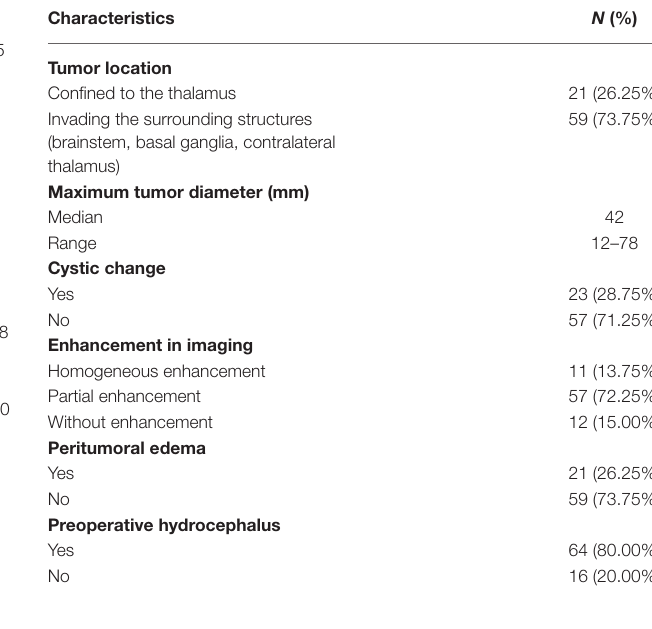
TABLE 2 | Summary of preoperative imaging characteristics in 80 patients.